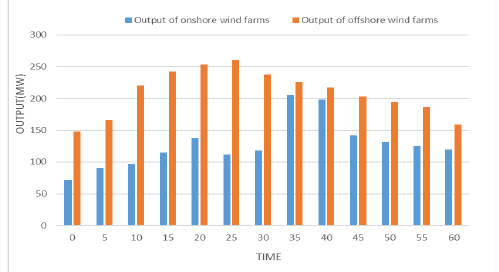
Fig. 2. Output power of wind farms.